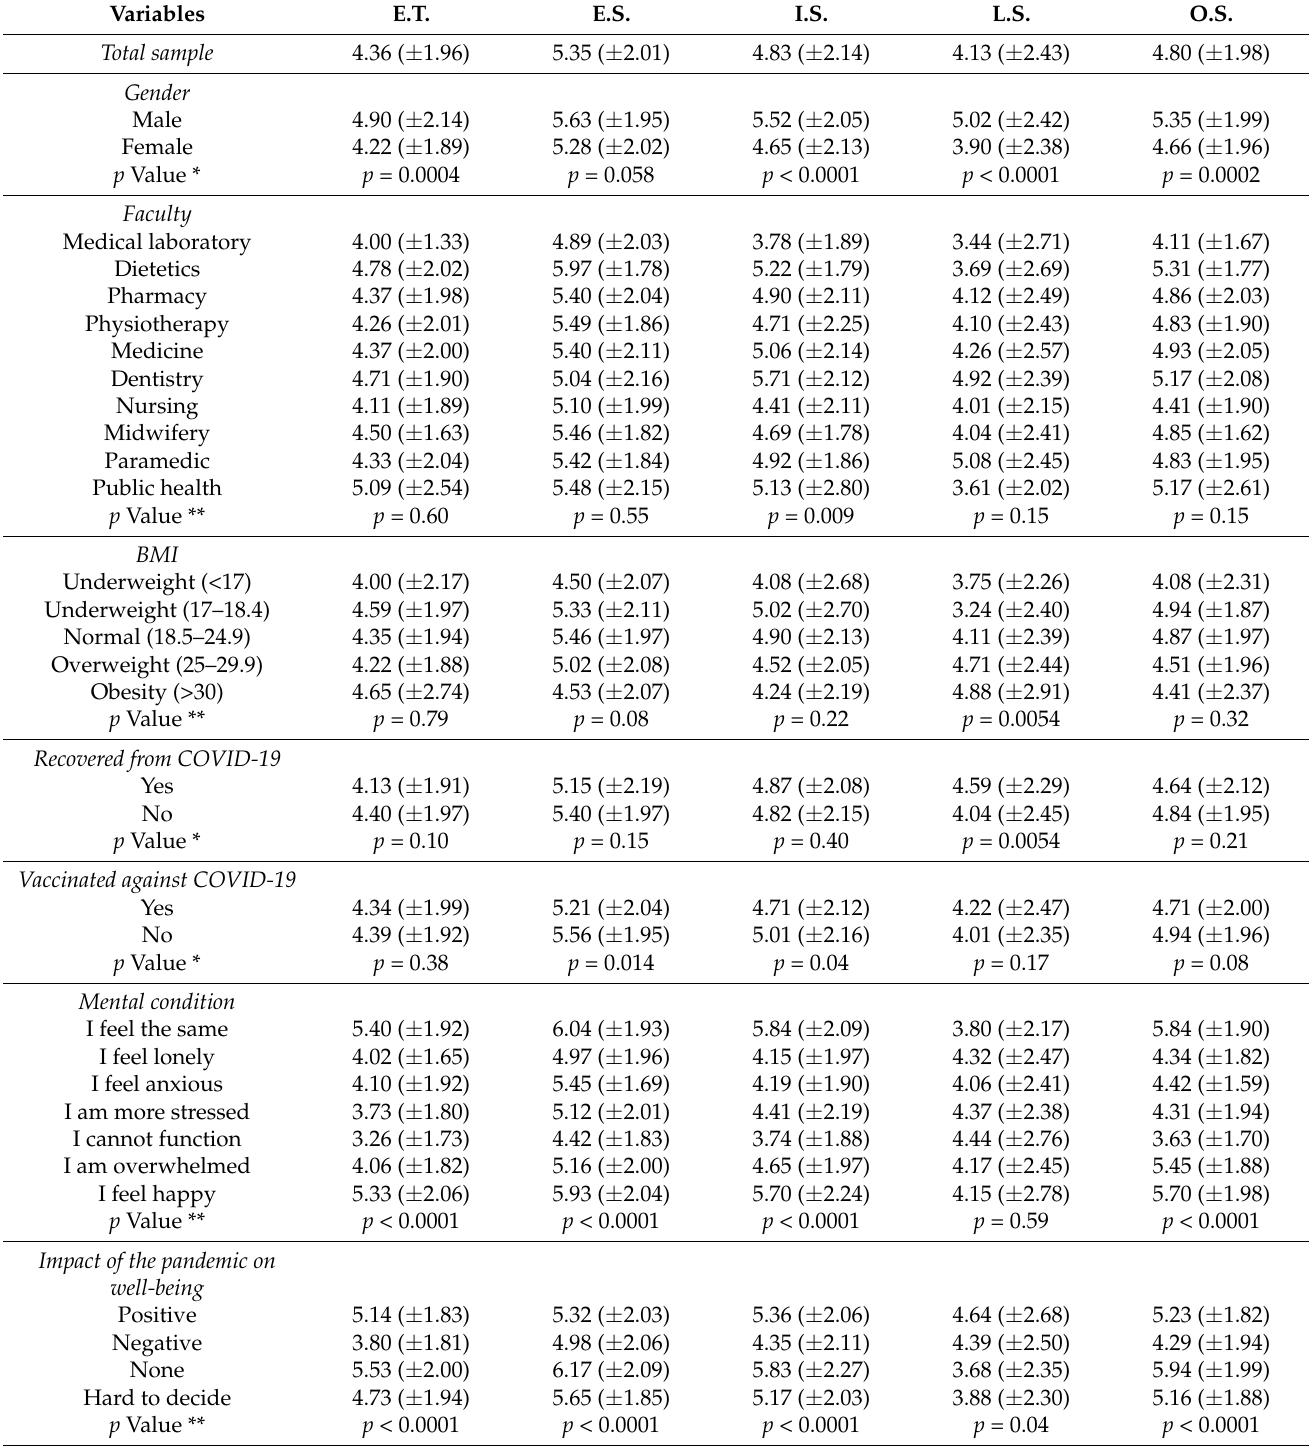
Table 3. Association between study variables and scores obtained on the KPS scale (mean score ± standard